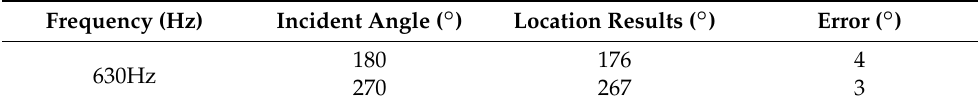
Table 2. Directional results and error values of each angle.